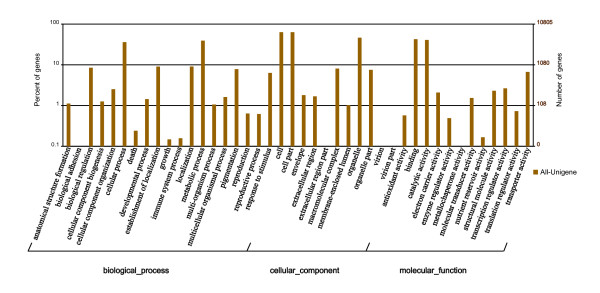
Gene ontology classification of assembled unigenes. The results are summarized into three main categories: biological processes, cellular components, and molecular functions. In total, 10,805 unigenes with BLASTx matches were assigned to gene ontologies.